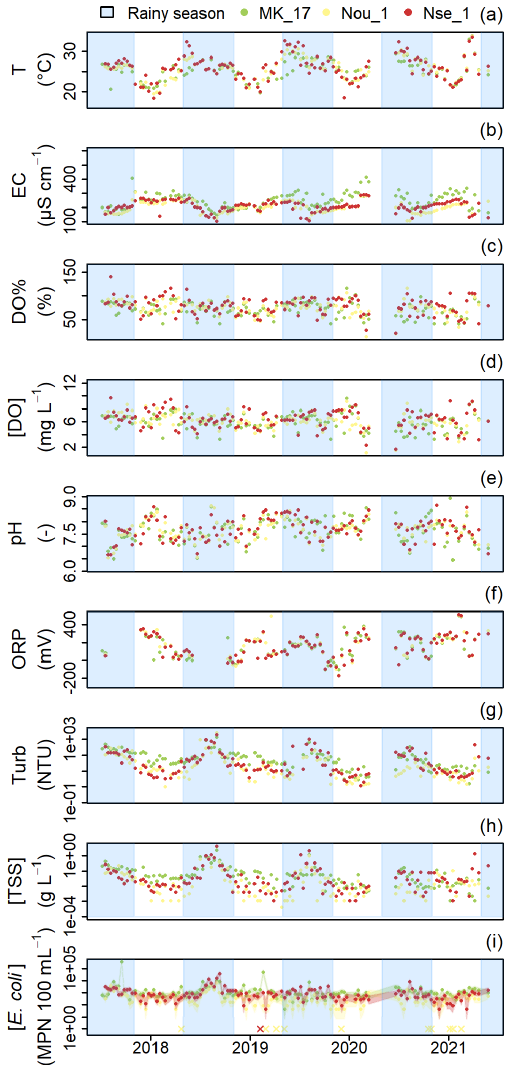
Figure 4. Stream water quality from 2017 to 2021 in the Mekong River at Luang Prabang (sampling station MK_17) and its trib- utaries Nam Ou and Nam Seuang (sampling stations Nou_1 and Nse_1, respectively), northern Lao PDR. T : temperature ( ◦ C); EC: electrical conductance at 25 ◦ C (µScm − 1 ); DO%: oxygen satu- ration (%); [DO]: oxygen concentration (mgL − 1 ); pH: pH (–); ORP: oxidation-reduction potential (mV); Turb: turbidity (NTU); [TSS]: total suspended sediment concentration (gL − 1 ); [ E. coli ]: Escherichia coli concentration (MPN 100mL − 1 ) with lower and upper limits of the confidence interval given by Poisson distribu- tion using the standardized microplate method. Turb, [TSS], and [ E. coli ] are shown with y axis as log scale. We added 0.0001 and 1 to all [TSS] and [ E. coli ] values, respectively, to present 0 values in a log scale, by convention. Crosses for [ E. coli ] represent [ E. coli ] below the detection limit. Blue polygons represent the rainy season from May to